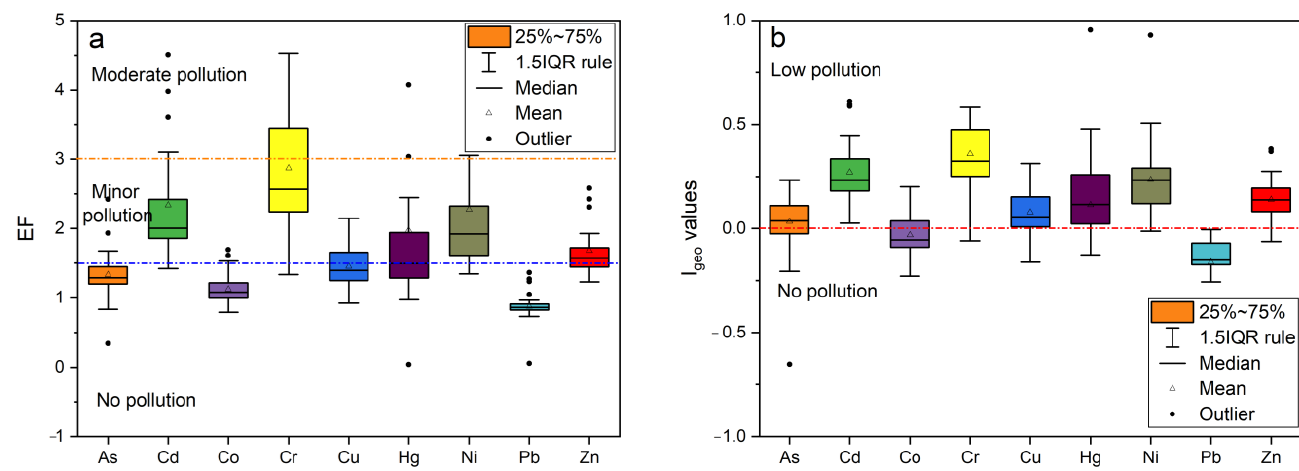
Figure 4. EF ( a ) and I geo ( b ) values of heavy metals for the 35 surface soils from Hetao Plain in Bayannur.